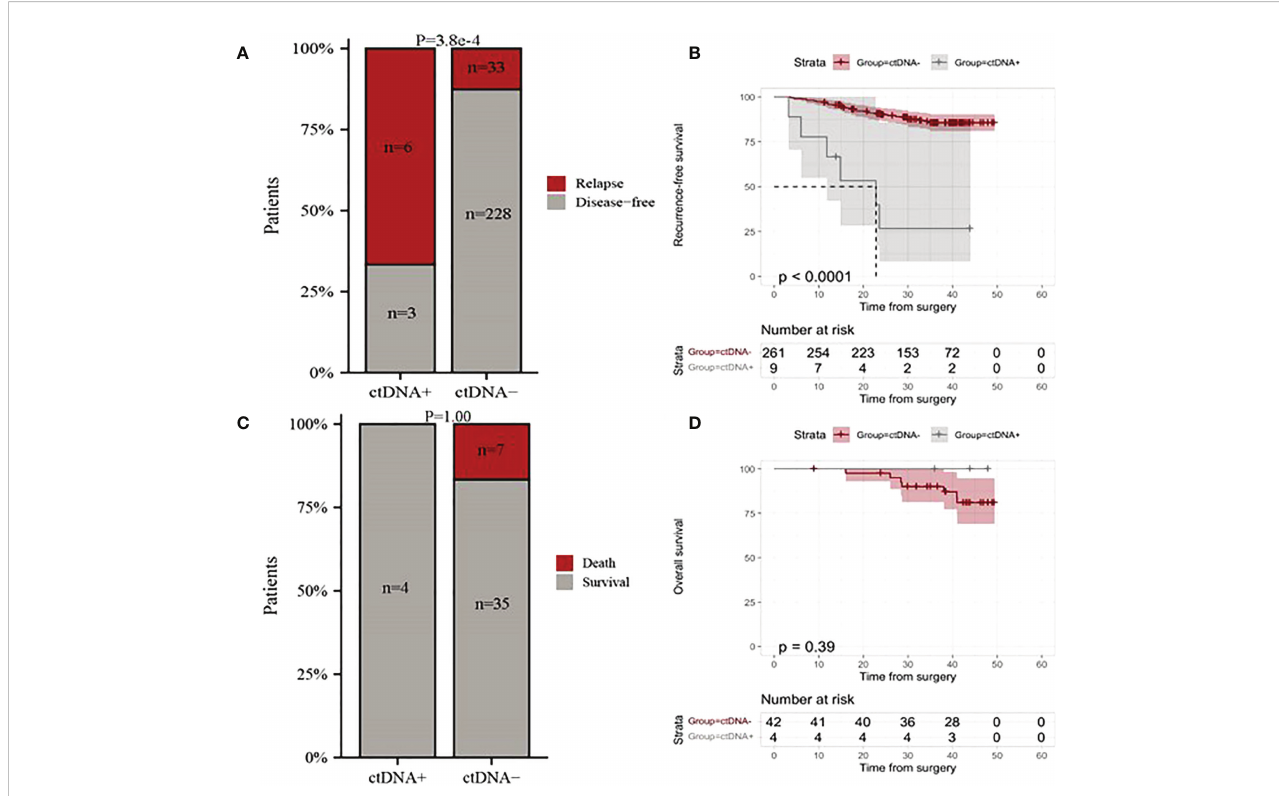
FIGURE 2 The relationship between postoperative ctDNA status and the risk of recurrence and death in resectable stage I NSCLC patients. (A) Comparison of overall relapse proportion between ctDNA-positive and ctDNA-negative patients. (B) Kaplan-Meier curves for recurrence-free survival (RFS) for patients with NSCLC strati fi ed by the postoperative ctDNA status. (C) Comparison of deaths proportion between ctDNA-positive patients and ctDNA-negative patients. (D) Kaplan-Meier curves for overall survival for patients with NSCLC strati fi ed by the postoperative ctDNA status. ctDNA+, ctDNA positive; ctDNA-, ctDNA